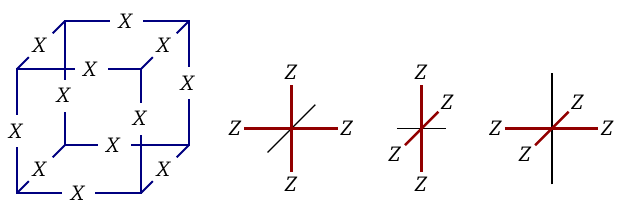
µ ) operators of the X-cube model Hamiltonian on v